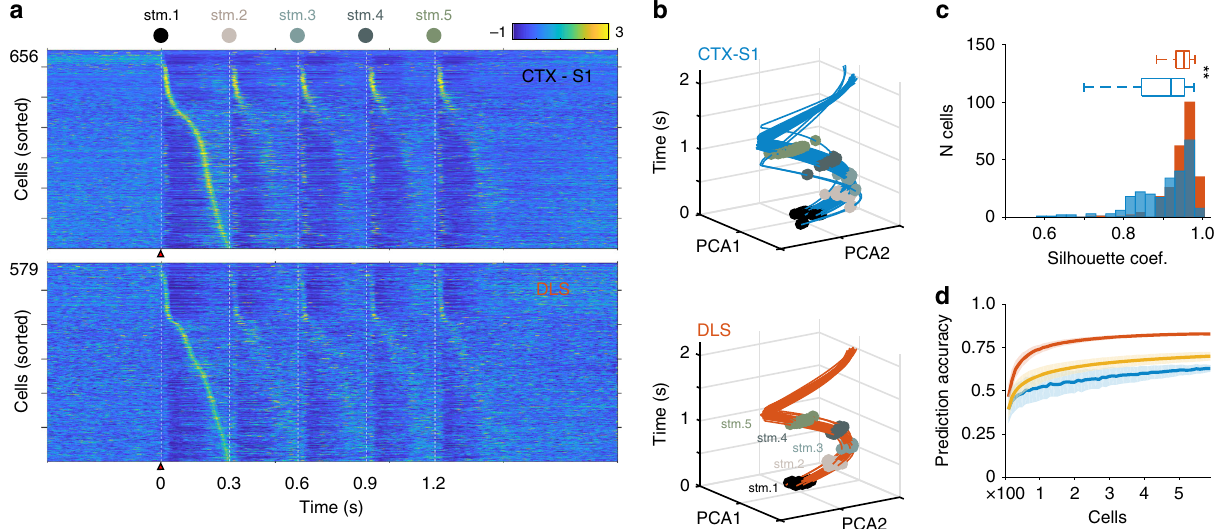
Fig. 3 Population representations of somatosensory sequential events. a Averaged fi ring rates ( Z -scores; 50 trains) for cells recorded in S1 (top) and DLS (bottom) during somatic train stimulations at 3.3 Hz. Neural activity was aligned to the fi rst stimulus of the sequence and neurons were sorted according to the time they reached the highest fi ring rate between the fi rst and second stimulus. b Low-dimensional projection of the population activity in S1 (top) and DLS (bottom) evoked by 50 stimulation trains. Dots correspond to the moments when the different stimuli of the train were presented. c Distribution of silhouette coef fi cients for the stimulus-evoked clusters in ( c ). ** Wilcoxon rank-sum test p < 0.001. d Comparison of Support Vector Machine classi fi er performance using cortical (blue), striatal (orange), and shuf fl ed (yellow) population activity as a function of the number of units used for training and testing. Randomly selected cells were progressively added in ten-cell steps until reaching the original population size. The procedure was repeated 500 times and the mean + SD of these values is